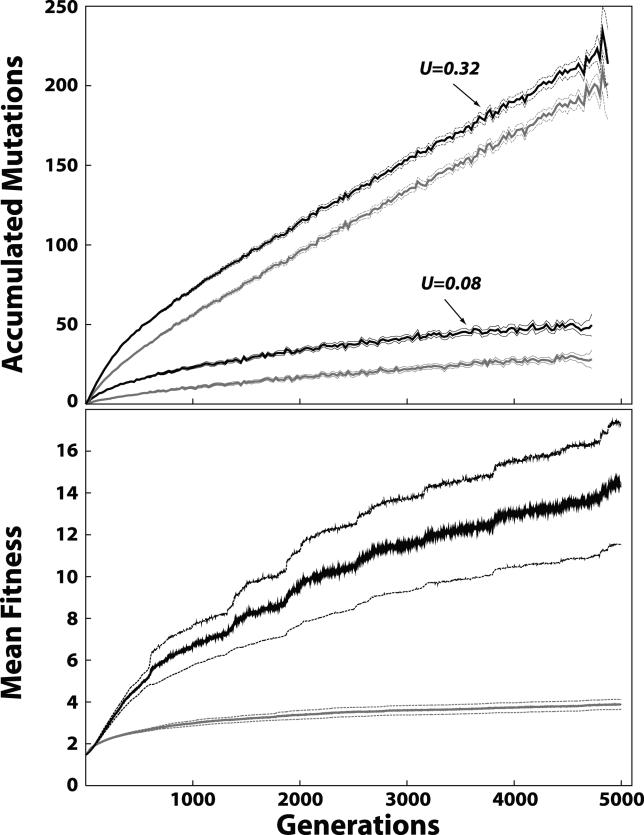
Mutation Accumulation and Mean Fitness of Evolving PopulationsThe top pane shows the accumulation of beneficial and deleterious mutations in the lineage leading to the MRCA, while the bottom pane shows the mean fitness of the populations over time. In both panes, the thicker lines represent the mean value, and the thin, dotted lines represent bounds for 95% confidence intervals. In the top pane, the dark lines represent beneficial mutations and the light lines represent deleterious mutations (see text for definition). The jaggedness in the lines is the result of averaging over all simulations, which frequently differ in the length of their MRCA lineages. Within any single run the number of mutations monotonically increases. In the lower pane, the dark lines correspond to U = 0.32 and the light lines correspond to U = 0.08.